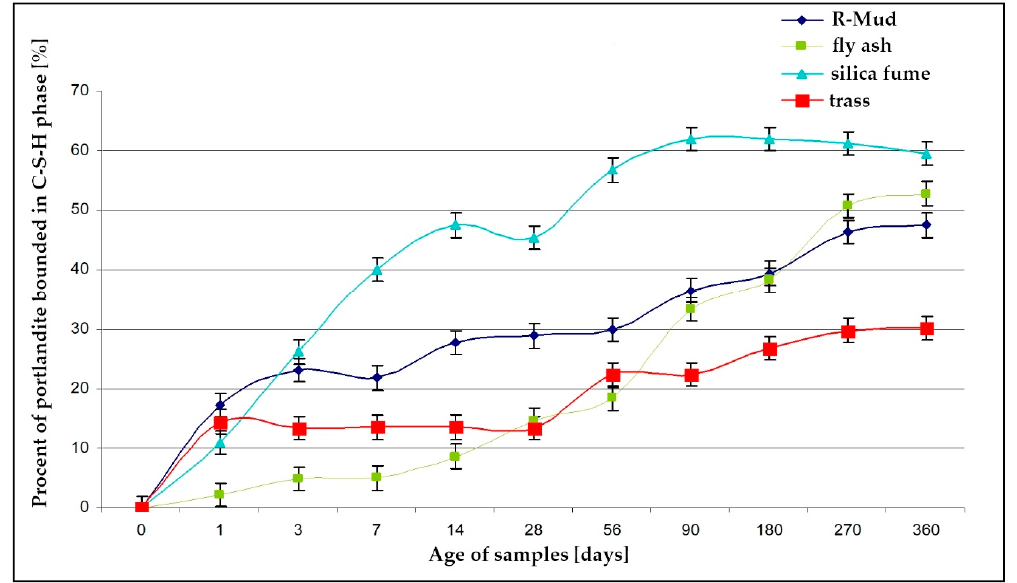
Figure 9. Pozzolanic activity of different materials as a percentage of conversion of portlandite into C ‐ S ‐ H phase.